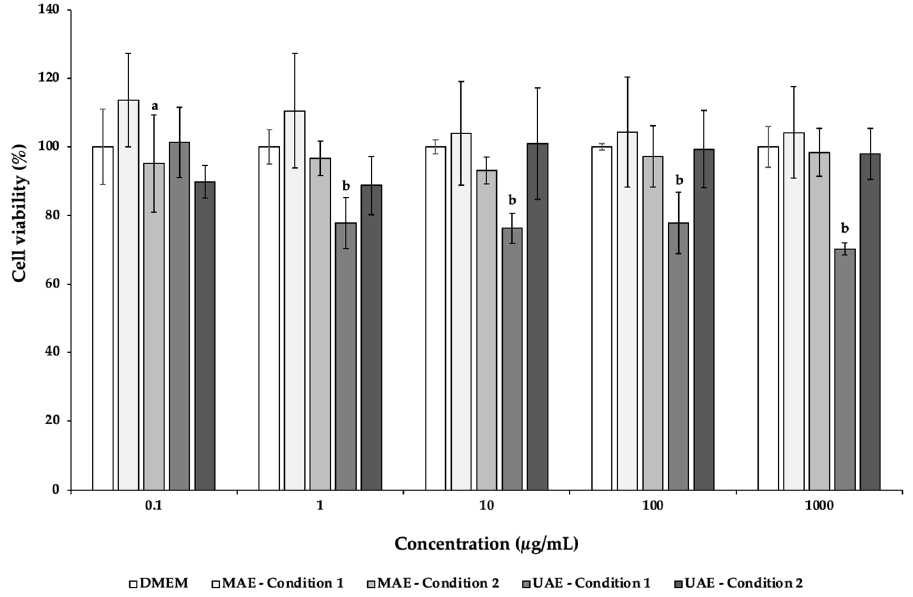
Appl. Sci. 2022 , 12 , 1763 11 of 16 Figure 1. Effects of C. pepo extracts obtained by UAE and MAE exposure on the viability of Caco-2 cells at different concentrations (0.1–1000 µ g/mL), measured by MTT assay. Values are expressed as mean ± standard deviation ( n = 3). Different letters represent significant differences between concentrations of the same sample ( p < 0.05), according to Tukey’s HSD test.